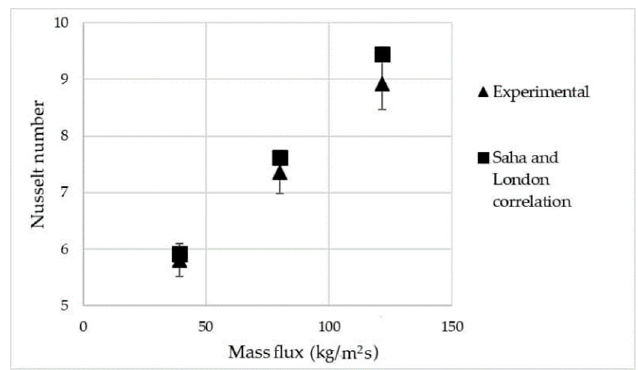
Figure 4. Validation of experimental results.